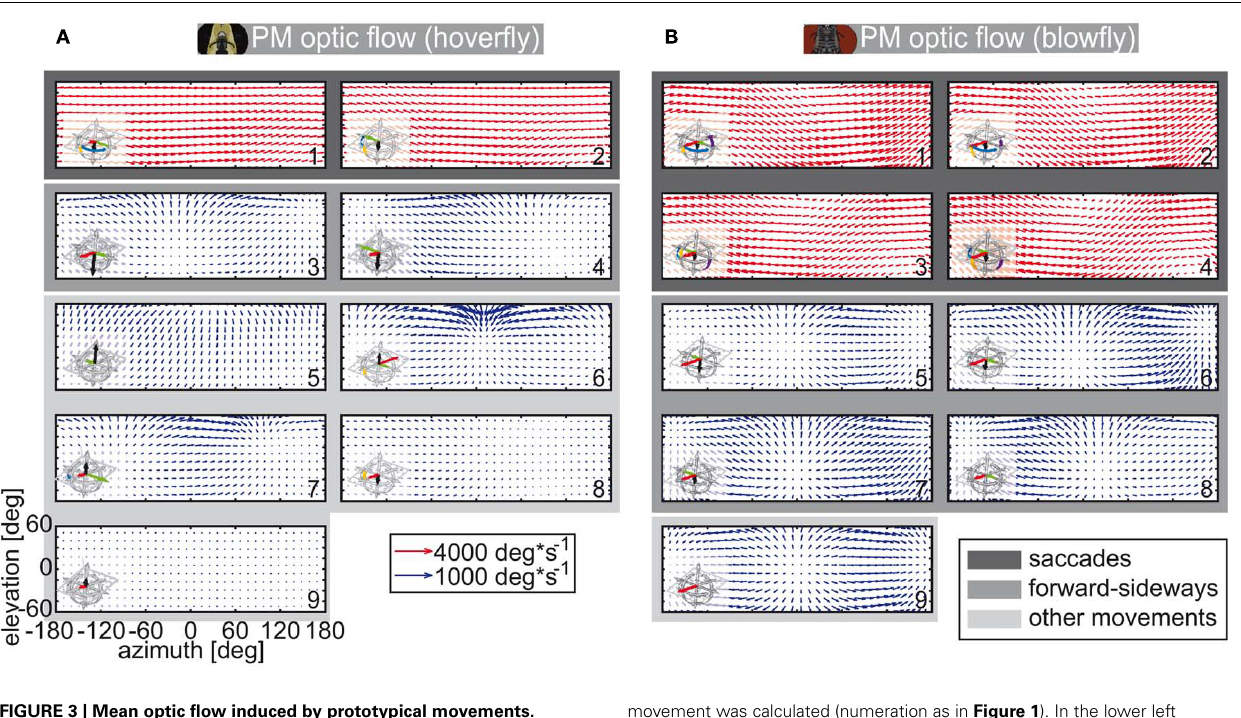
FIGURE 3 | Mean optic flow induced by prototypical movements. Optic flow calculated geometrical from head trajectories of both species. The red arrows are scaled differently than the blue ones (they code for four times the velocity of the blue arrows). A field of view of 120˚ elevation is depicted.The mean optic flow for each prototypical